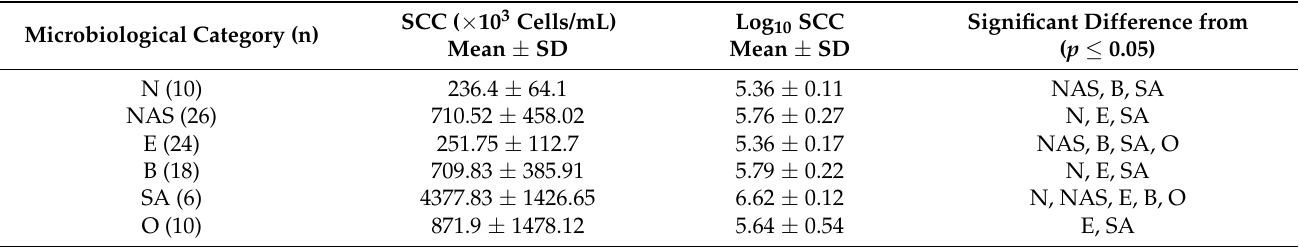
Table 2. SCC and log-transformed SCC and standard deviation by microbiological category based on BLAST analysis of 16S rRNA gene sequence in 76 composite mid-lactation milk samples from Carpathian goats without signs of clinical mastitis in Romania.